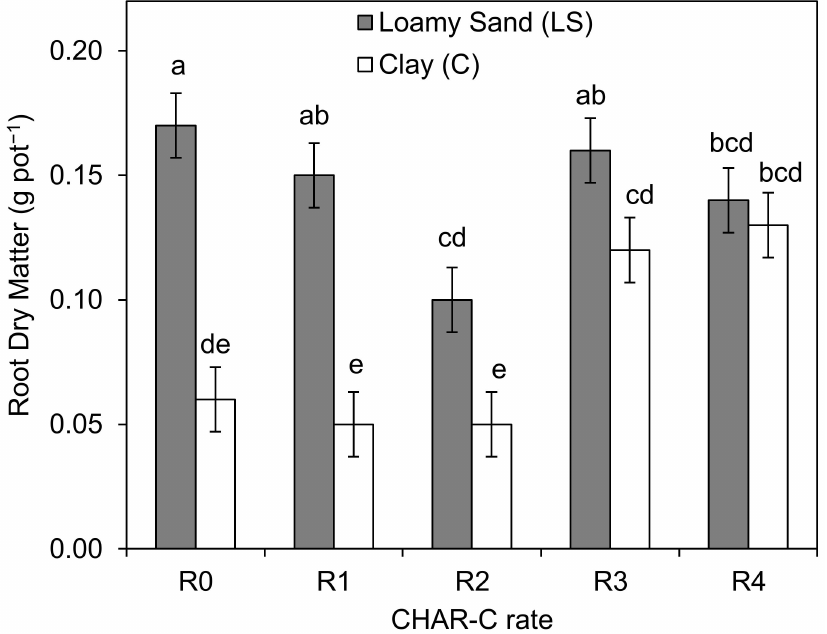
Figure 8. Root dry matter of S. saccharatum (L.). The mean values marked with the same letters do not differ significantly at p < 0.05 (according to Dancan’s test). R0, R1, R2, R3 and R4 correspond to